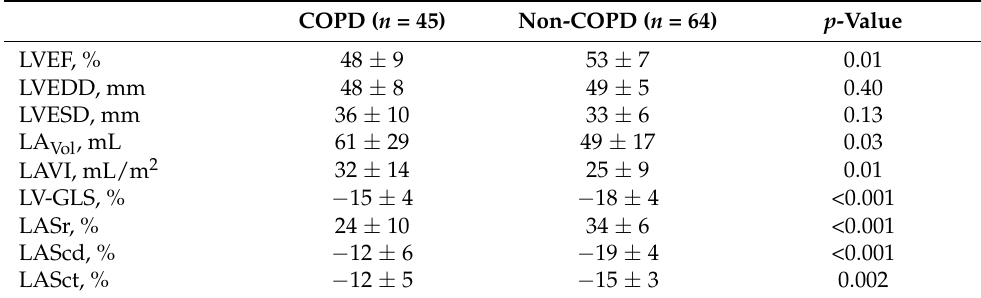
Table 2. Echocardiography in patients with versus without COPD.